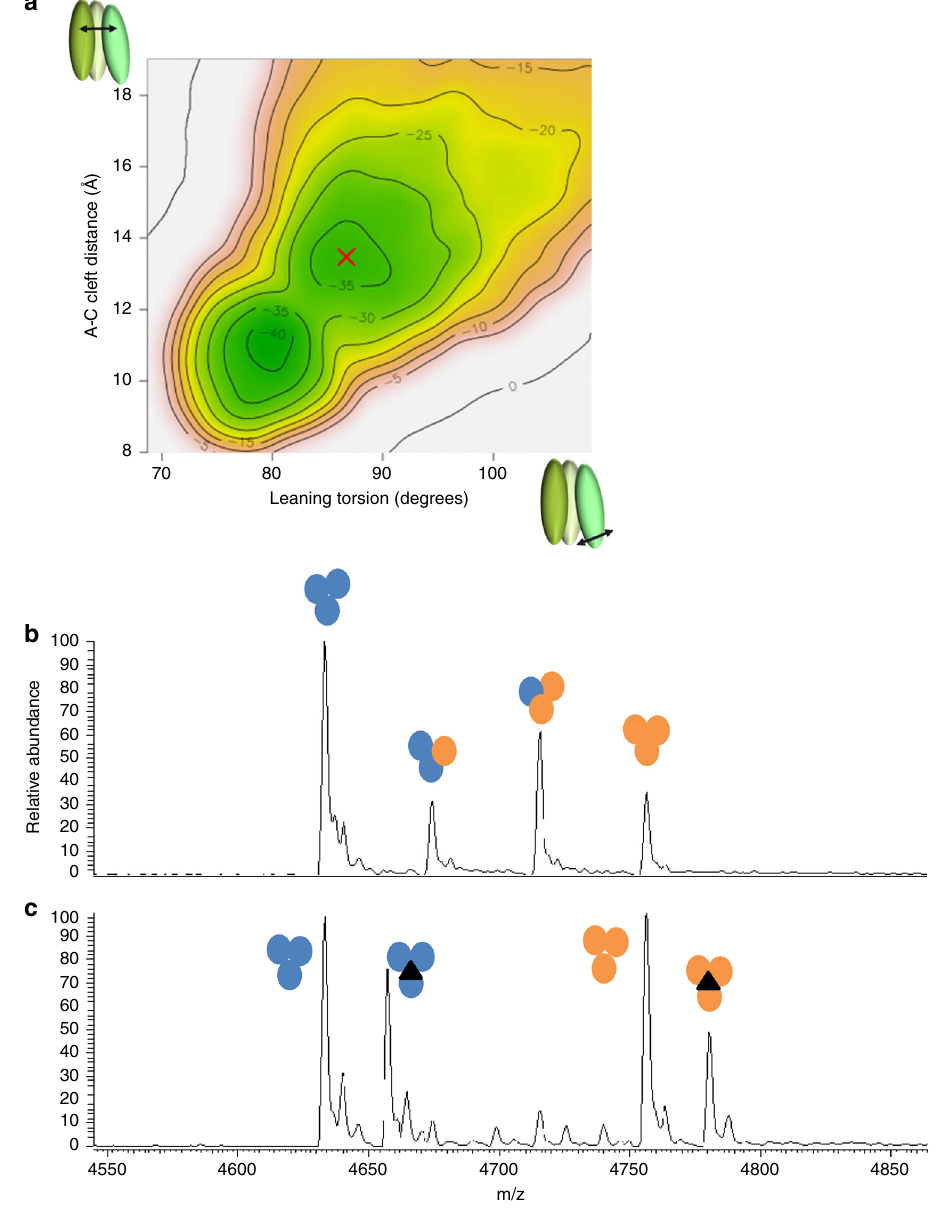
Fig. 3 TNF stabilisation by molecular dynamics and monomer exchange. a Meta-dynamics molecular dynamics simulation was used to produce this free- energy surface. The simulation used a torsion describing the leaning angle of subunit A with respect to the other subunits and a distance describing how open the AC cleft is. b Mass spectrometry analysis of a mixture of human TNF (orange circles) and mouse TNF (blue circles) showing peaks corresponding to homotrimers and heterotrimers. c An equivalent analysis using human TNF pre-incubated with UCB- 6876 (black triangle) showing that the compound blocks the exchange of mouse and human